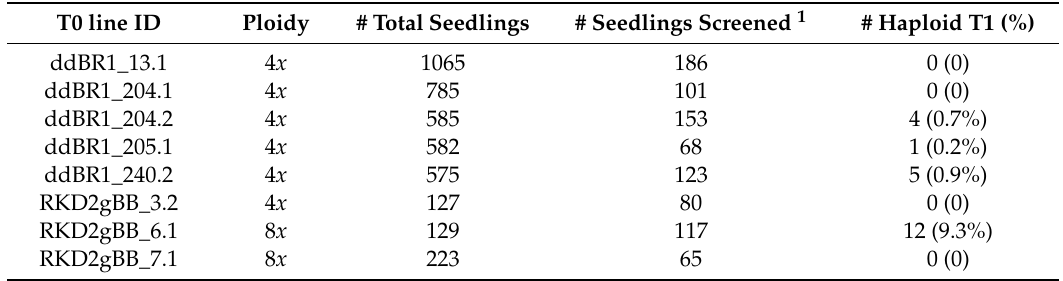
Table 1. E ffi ciency of haploid production in the haploid-producing T0 after